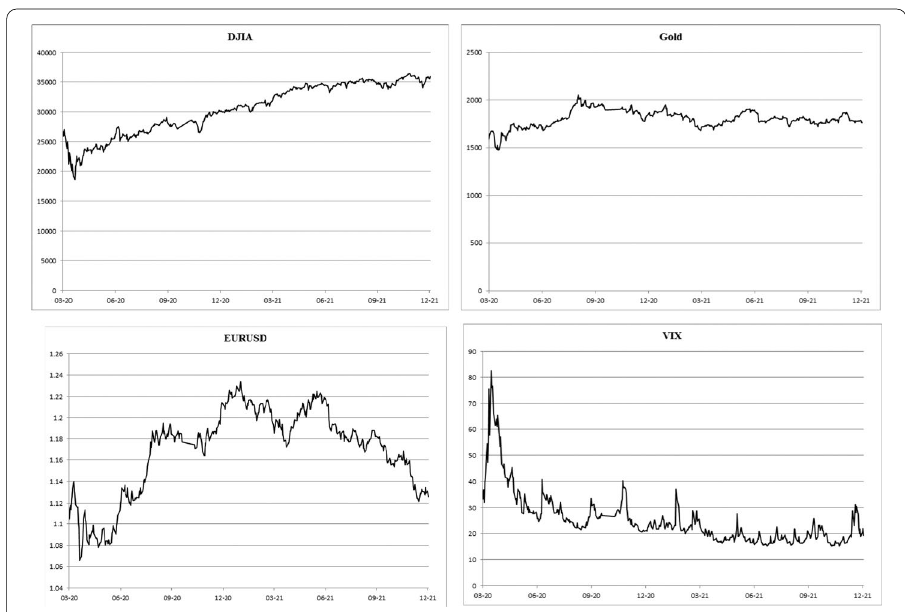
Fig. 2 Price evolution of the DJIA, GOLD, EURUSD, and VIX during the COVID-19